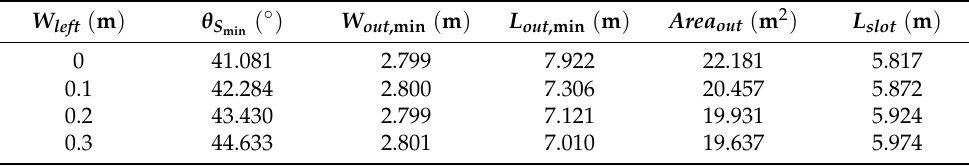
Table 3. Variation of external parking space dimension data with W left